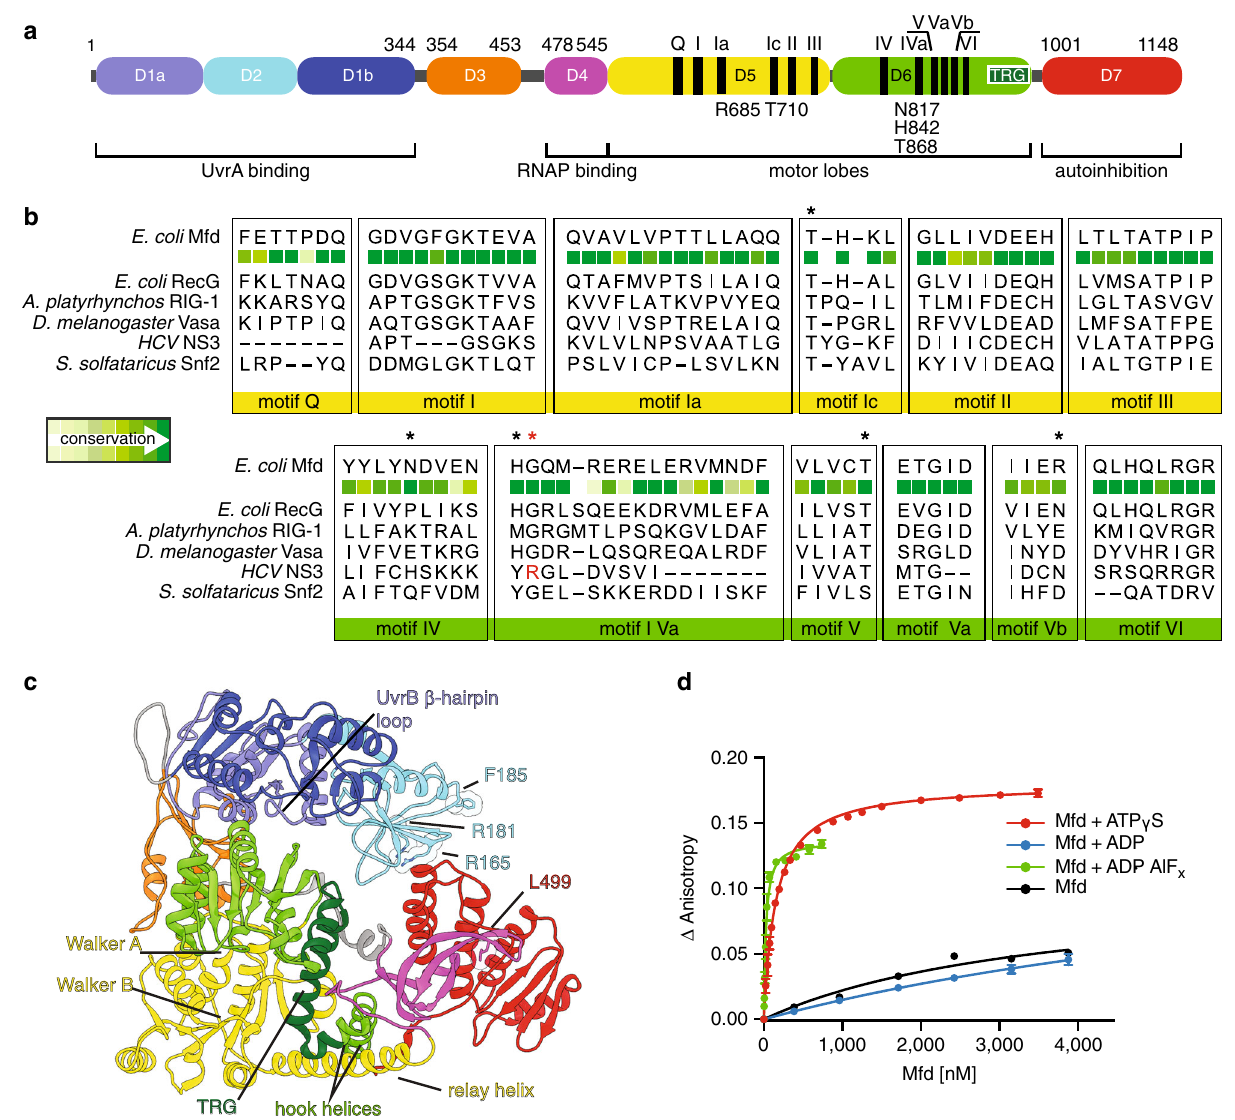
Fig. 2 DNA binding by Mfd becomes tightest in the presence of transition state analog ADP • AlF x . a Domain organization of E. coli Mfd with annotated conserved sequence motifs and key residues mutated in this study. b Structure-based sequence alignment of the ATPase motifs of Mfd and other dsDNA and ssDNA translocases used for structural modeling purposes. Mutated residues are indicated by asterisks and sequence conservation, based on an alignment of Mfd proteins is color-coded from dark green (strongly conserved) to light green (variable). ATPase domain motifs are shown underneath for Escherichia coli RecG, Sulfolobus solfataricus Swi2/Snf2, Drosophila melanogaster Vasa, HCV NS3, and Anas platyrhynchos RIG-1. The arginine clamp R393 of HCV NS3 is shown in red. c Structural overview of nucleotide-free E. coli Mfd (PDB ID 2EYQ) colored by domain and with annotated ATPase motifs and key structural elements. Shown as CPK models are residues implicated in UvrA and RNAP binding 29,31 . d Fluorescence anisotropy DNA-binding curves for Mfd in distinct nucleotide states: nucleotide-free (black), with 2 m M ATP γ S (red), ADP (blue), or ADP • AlF x (green). Error bars represent S.D.M. ( n = 3) and are often smaller than symbols. Curves obtained in the absence/presence of ATP γ S and ADP are replotted for convenience from the study by Le et al. 16 Source data are provided as a Data Source fi